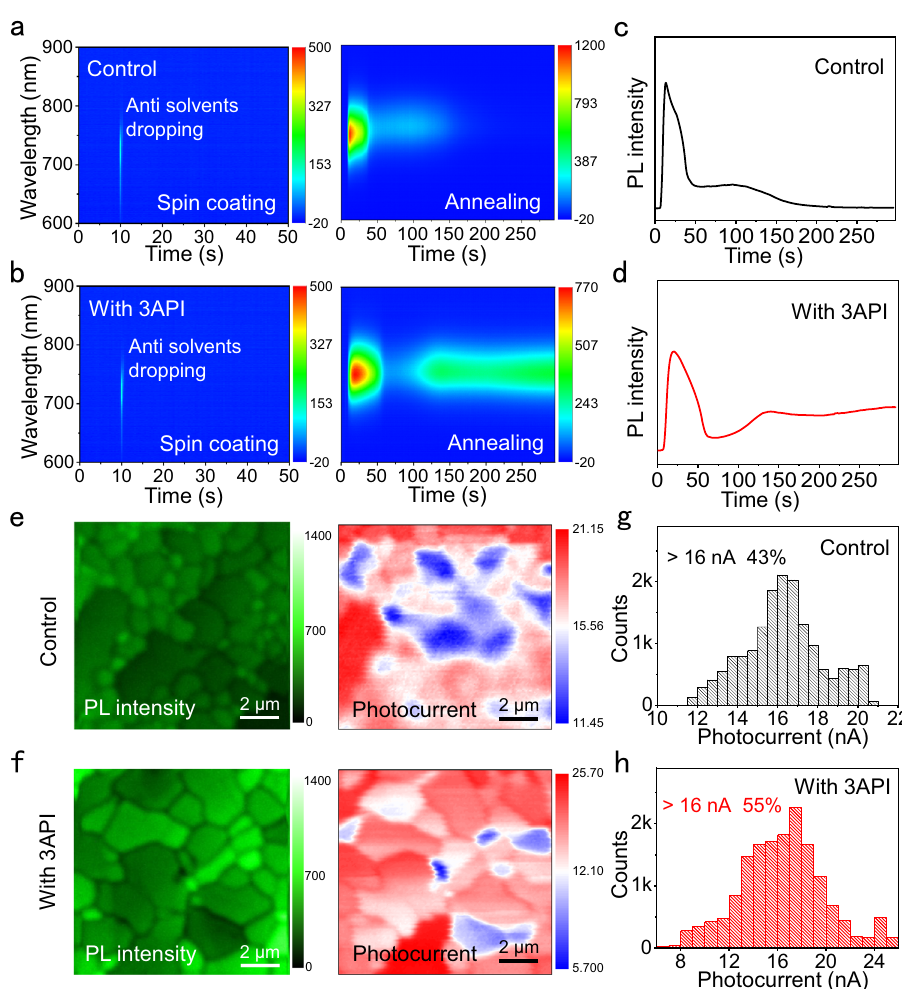
Fig. 4 | Stacking defects during fi lm formation and in the working devices. a , b In situ PL spectra of fi lms with or without 3API during spin coating and annealing. c , d The PL intensity extract from a and b . e , f PL intensity and